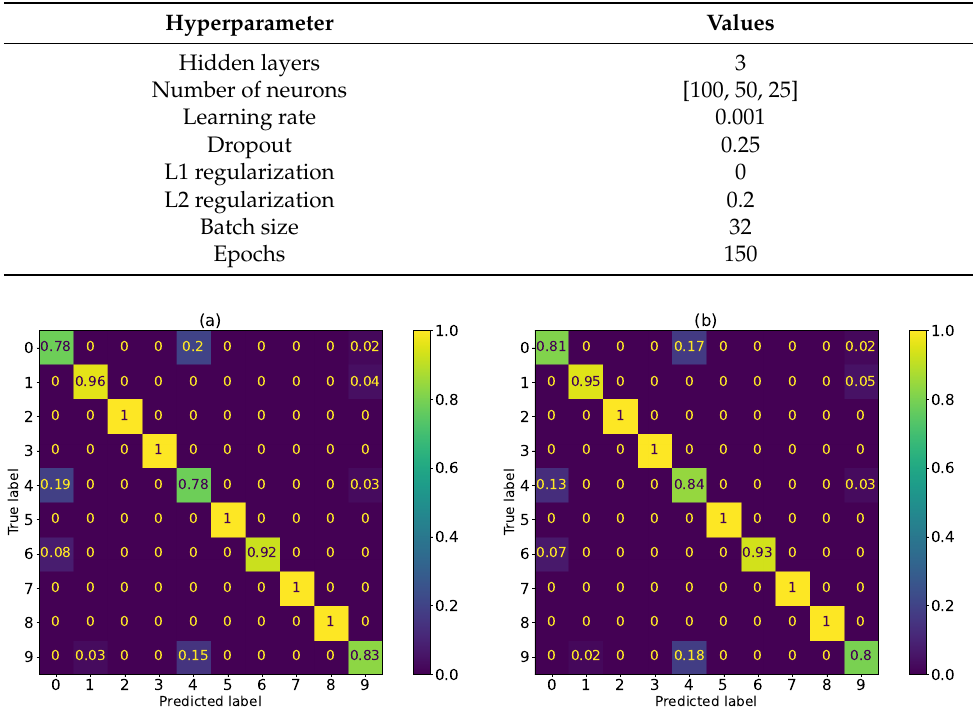
Figure 9. Confusion matrix with results of accuracy for each fault case for the training data ( a ) and test data ( b ). 0: healthy state; 1: undervoltage; 2: unsymmetrical voltage; 3: open phase; 4: broken bar; 5: winding short circuit; 6: mixed eccentricity; 7: bearing—outer ring fault; 8: bearing—inner ring fault; 9: bearing—global